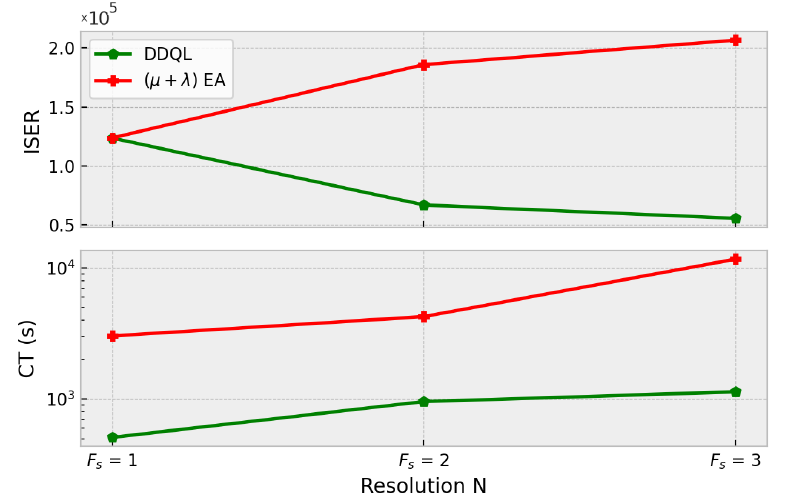
Figure 20. ISER ( up ) and computation time ( down ) for different fleet sizes. When the number of agents increases, the EA cannot find good solutions with the same amount of samples as the